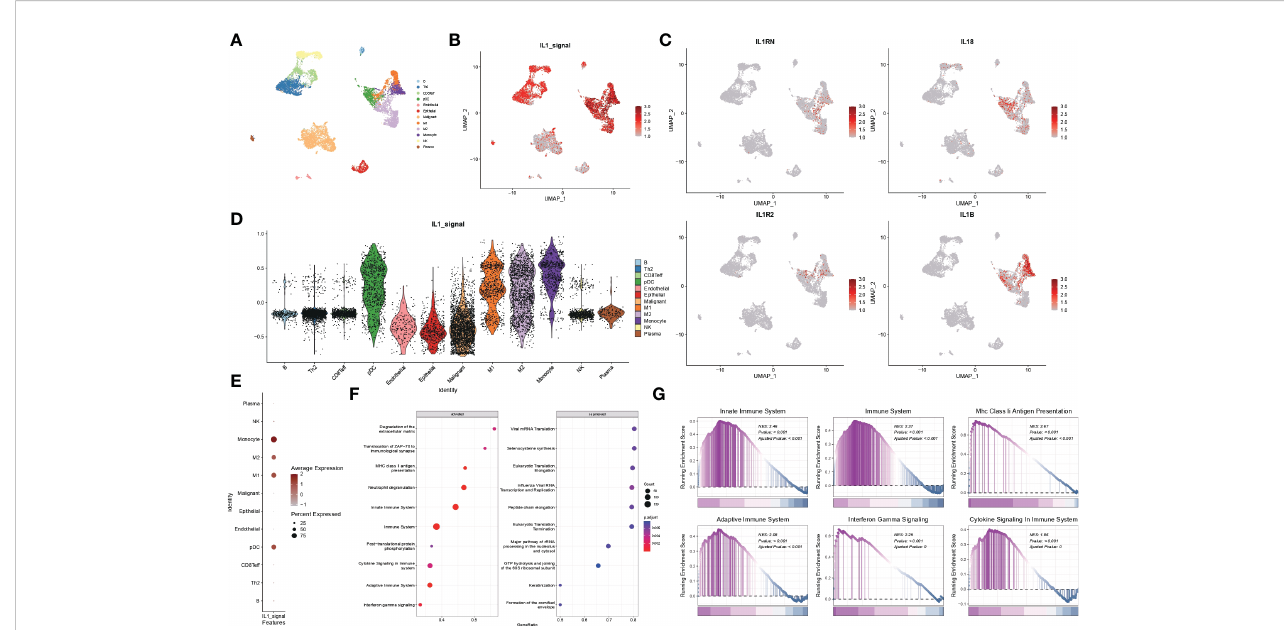
FIGURE 7 scRNA-seq data from GSE117570. (A) Single-cell analysis of UMAP from lung adenocarcinoma patients divided into 12 cell subgroups. (B) Distribution of IL1-score in single-cell descending space. (C) Speci fi c expression of individual subtypes of IL-1 in various types of immune cells. (D) Violin diagram showing the distribution of IL-1score in various subpopulations of cells. (E) Dot plots showing the percentage expression of immune cell subpopulations. (F, G) Functional analysis of myeloid cells using GSEA.